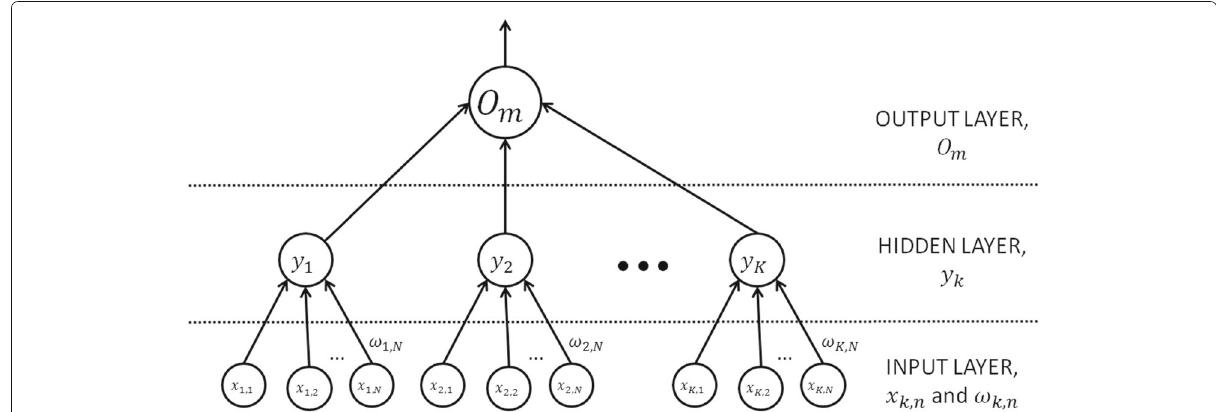
Fig. 1 TPM diagram. The TPM neural network consists of input, hidden, and output layers to generate keys from its